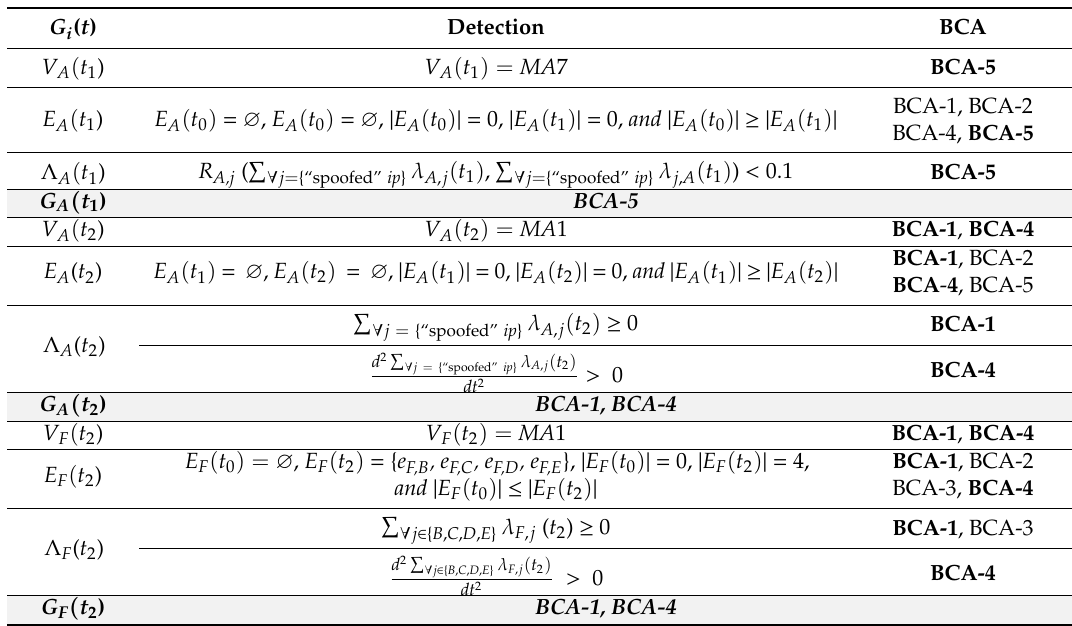
Table 9. BCA detection in Scenario 4 (BCA-5 detection on host A at t 1 ; detection of BCA-1 and BCA-4 on host A and F at t2